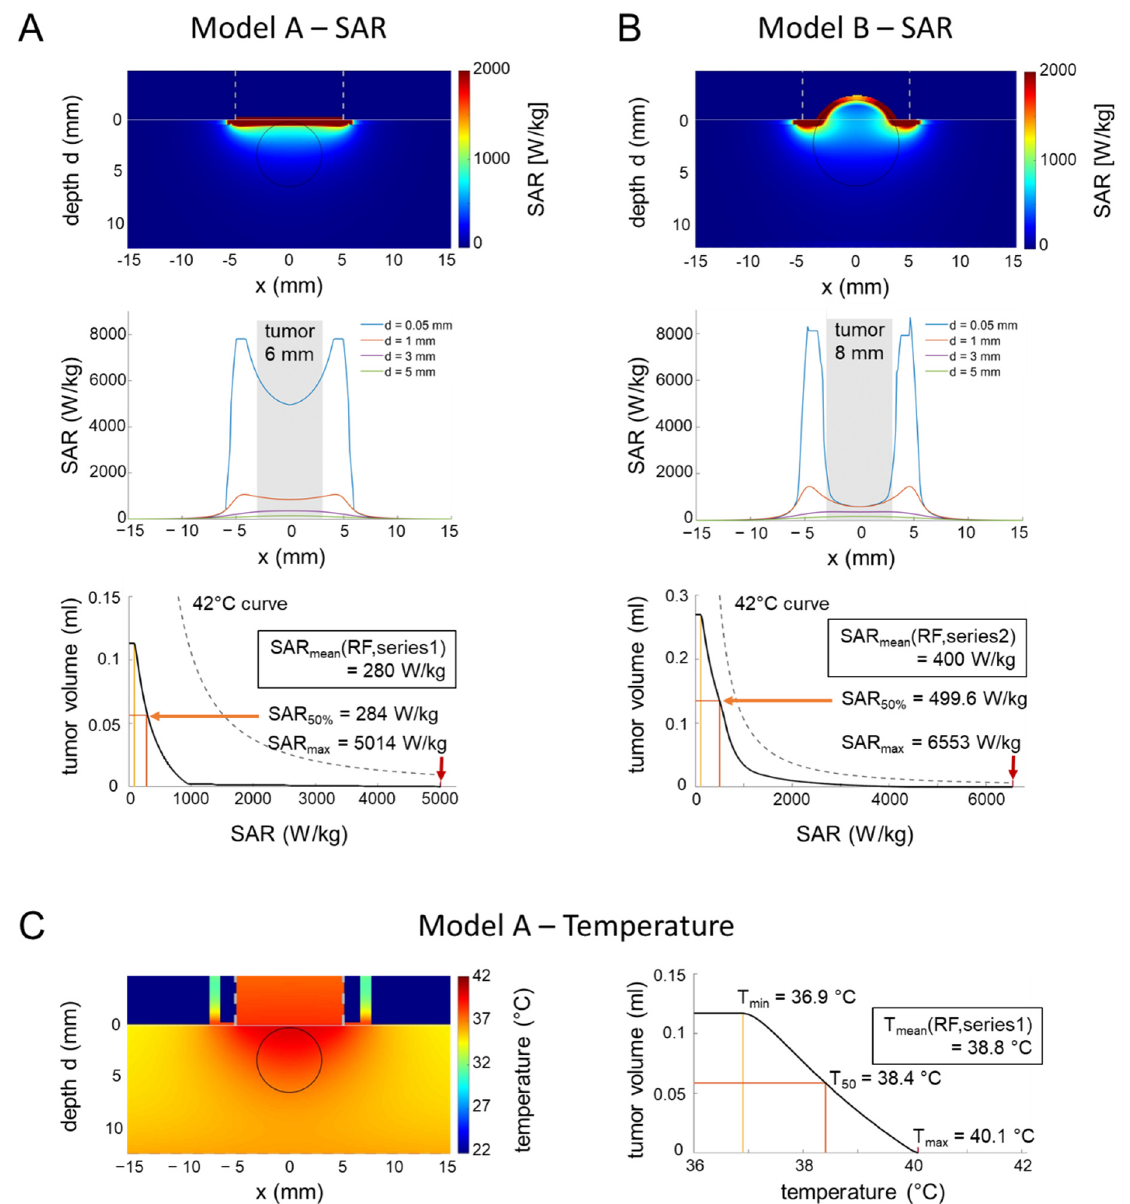
Figure 7. ( A ) SAR simulations in an in vivo applicator (small tumor). Two-dimensional SAR distribution (top), depth profiles near the surface (middle), and SAR volume histogram of the tumor for model A representing series 1 with small tumors (6 mm in diameter) during the induction phase. The SAR volume histogram of the tumor is far below the 42 °C curve. SAR min , SAR 50% and SAR max are marked with yellow, orange and red markers respectively. However, overheating might be possible outside the tumor at the applicator edge under unfavorable conditions (see profile at depth d = 0.05 mm). ( B ) SAR simulations in an in vivo applicator (large tumor). For model B with larger tumors (8 mm in diameter), the SAR volume histogram yields higher SAR than for model A but is still below the 42 °C curve (please note the adapted scale of the y-axis). Similar to model A, over- heating might be possible outside the tumor at the applicator edge with similar SAR peaks (see the